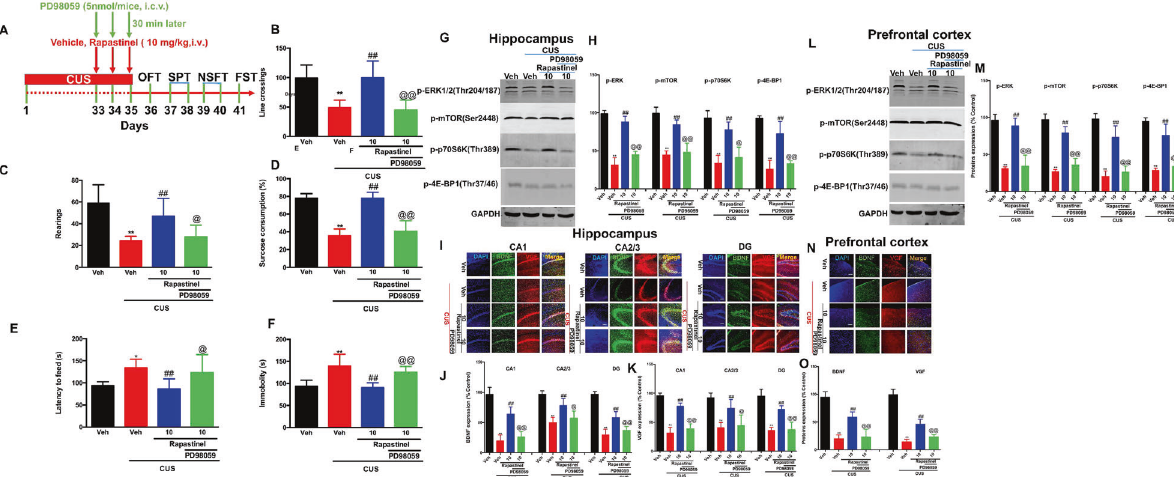
Fig. 4 Inhibition of ERK signaling signi fi cantly abolishes the antidepressant-like actions and upregulation of VGF, BDNF, and ERK/mTOR signaling produced by repeated treatment with rapastinel in mice. A Schematic demonstrating the timeline for cannula implanted, CUS exposure, drug treatment, and behavioral tasks. B , C Pretreatment with PD98059 signi fi cantly alleviated effects of rapastinel on CUS-induced decrease of locomotor activity in the OFT, as assessed by line crossings ( B ) and rearings ( C ). D Inhibition of ERK signaling blocks the rapastinel treatment rapidly reversed anhedonia as measured by a reduction in 1% sucrose preference after CUS. E Rapastinel administration rapidly reversed the changes in latency to feed in the NSFT. F Rapastinel signi fi cantly prevented CUS-induced increase in immobility time in FST. G and L Representative western blot images; H and M Quantitative analysis of blots (p-ERK, ERK, p-mTOR, p-p70S6K, and p-4E-BP1). C Immuno fl uorescent images of BDNF and VGF in the CA1, CA2/3, and DG regions in the hippocampus ( I ) and PFC ( N ) of mice. Rapastinel reversed the CUS-induced downregulation of expression of BDNF (green) with VGF (red) in hippocampus ( J and K ) and PFC ( O ) neurons in mice. PD98059 can abolish the antidepressant effect of rapastinel in the expression of BDNF (green) and VGF (red) in hippocampus and PFC neurons in mice. Scale bar = 200 μ m. Data are expressed as means ± S.E.M; n = 9 for behavioral tasks, n = 3/mice for western blot and n = 5/ mice for immuno fl uorescence; ** P < 0.01 compared with the vehicle + non-stressed group; ## P < 0.01 compared with the vehicle + CUS group; @ P < 0.05, @@ P < 0.01 compared with the rapastinel + CUS